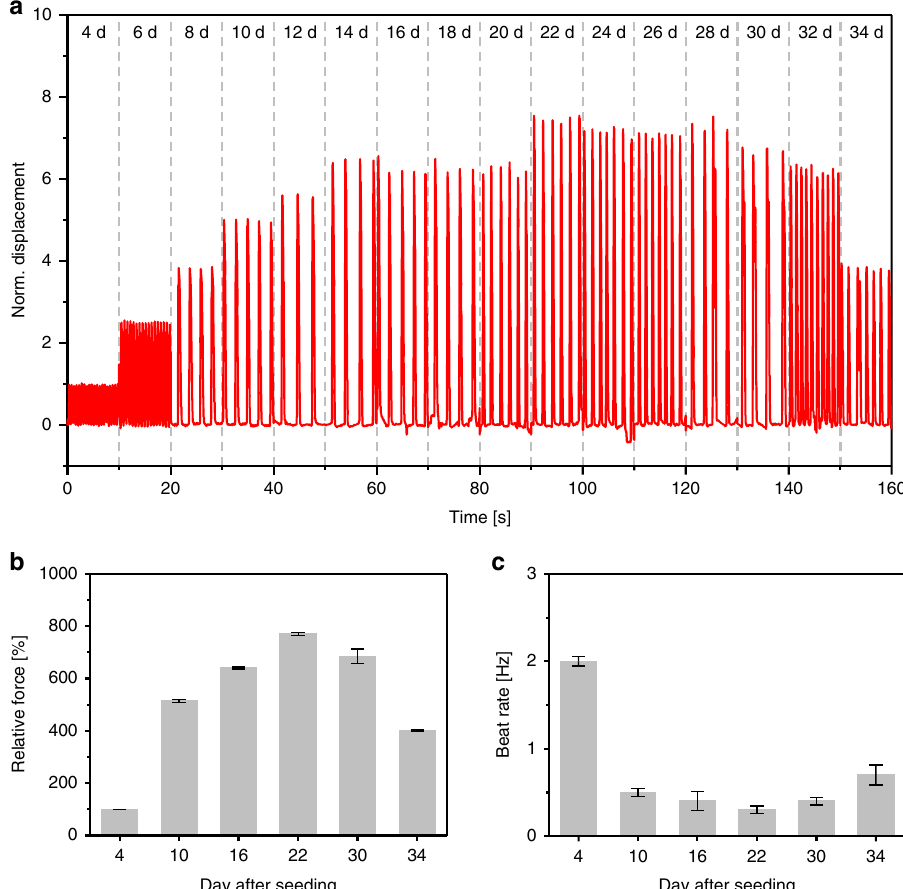
Fig. 5 Real-time measurement shows the change in contractility of the cultured cardiomyocytes. a Normalized cantilever displacement owing to the contraction and relaxation of the cultured cardiomyocytes. b , c Relative contraction force, and beating rate of the cardiomyocytes at different maturation days. Error bars are mean ± s.d., n = 5 biologically independent